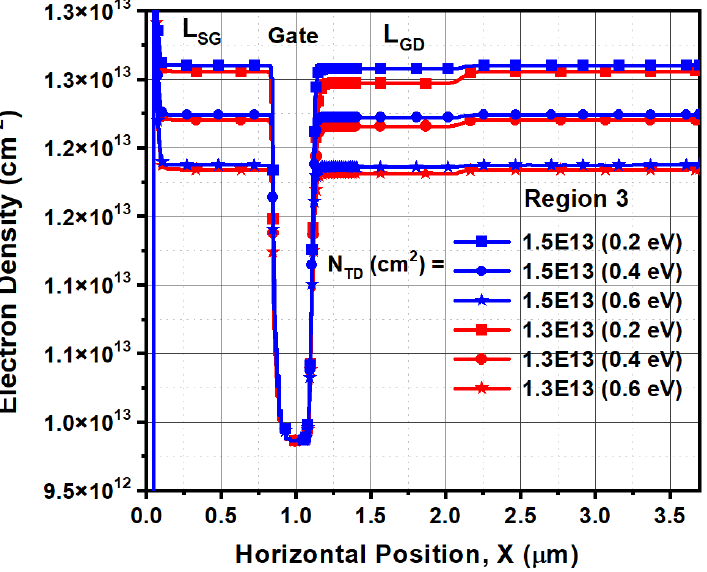
Figure 9. The 2DEG density versus lateral device distance (X) attained for various E TD and N TD values under the thermal equilibrium condition for Region 3.